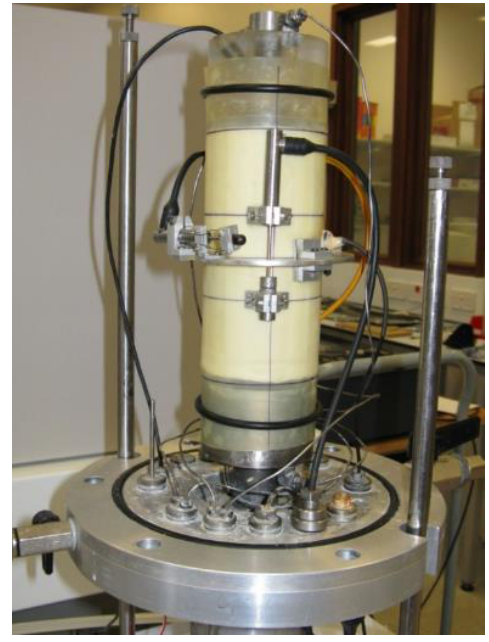
Figure 3. LVDT mounted on a sample (source: photo of Kowalska M., after [41]; available via 2021 Civil and Environmental Engineering’s permission).